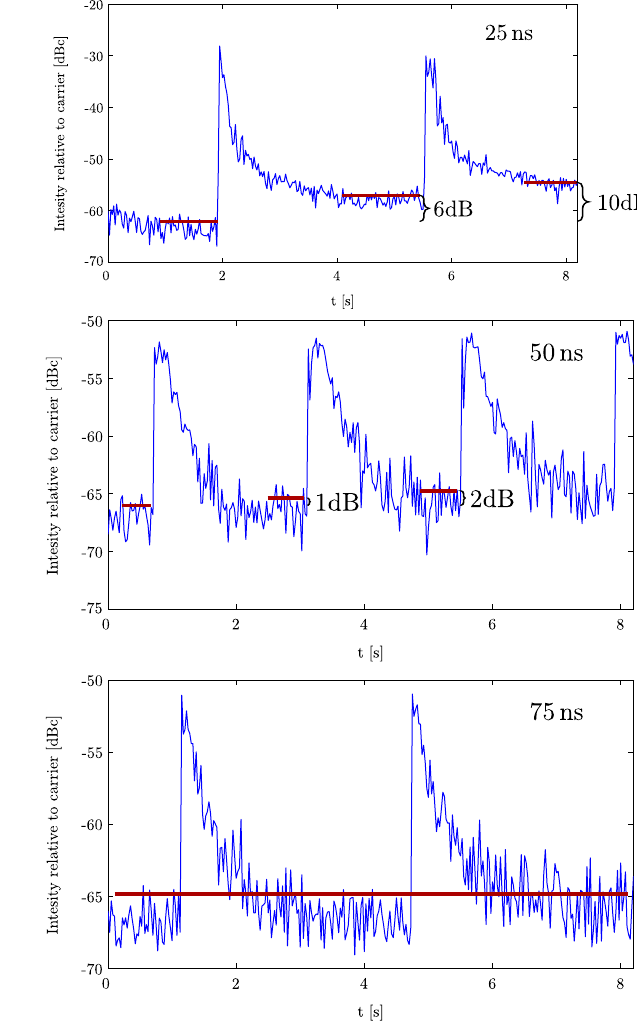
FIG. 10. Comparison of phase modulation signals, measured for the uncoated SPS vacuum chamber, using the nominal LHC beams with 25, 50, and 75 ns bunch spacing. The data were taken with beams of four batches at SPS flat